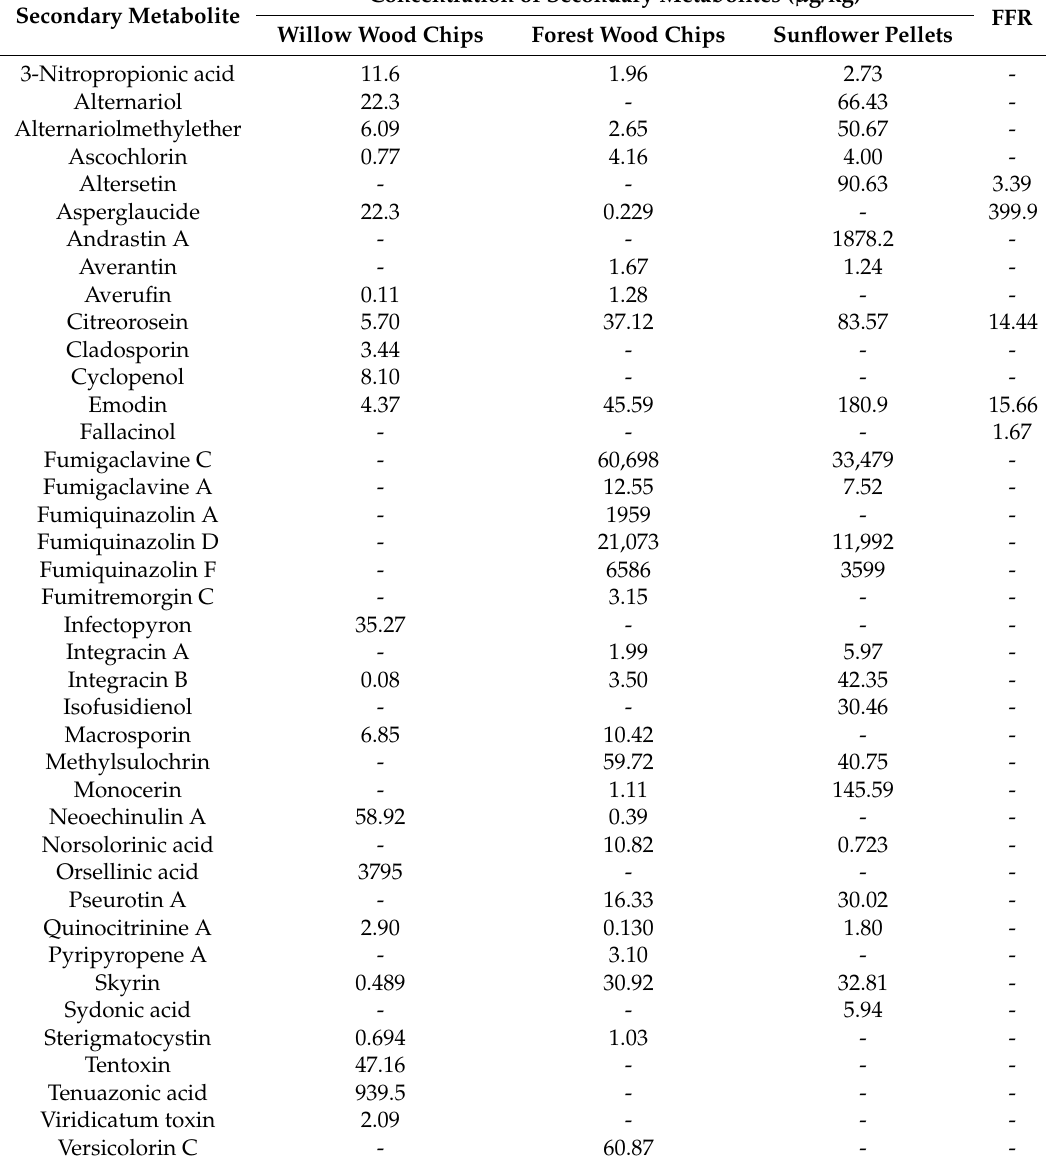
Table 7. Secondary metabolites detected in biomass and